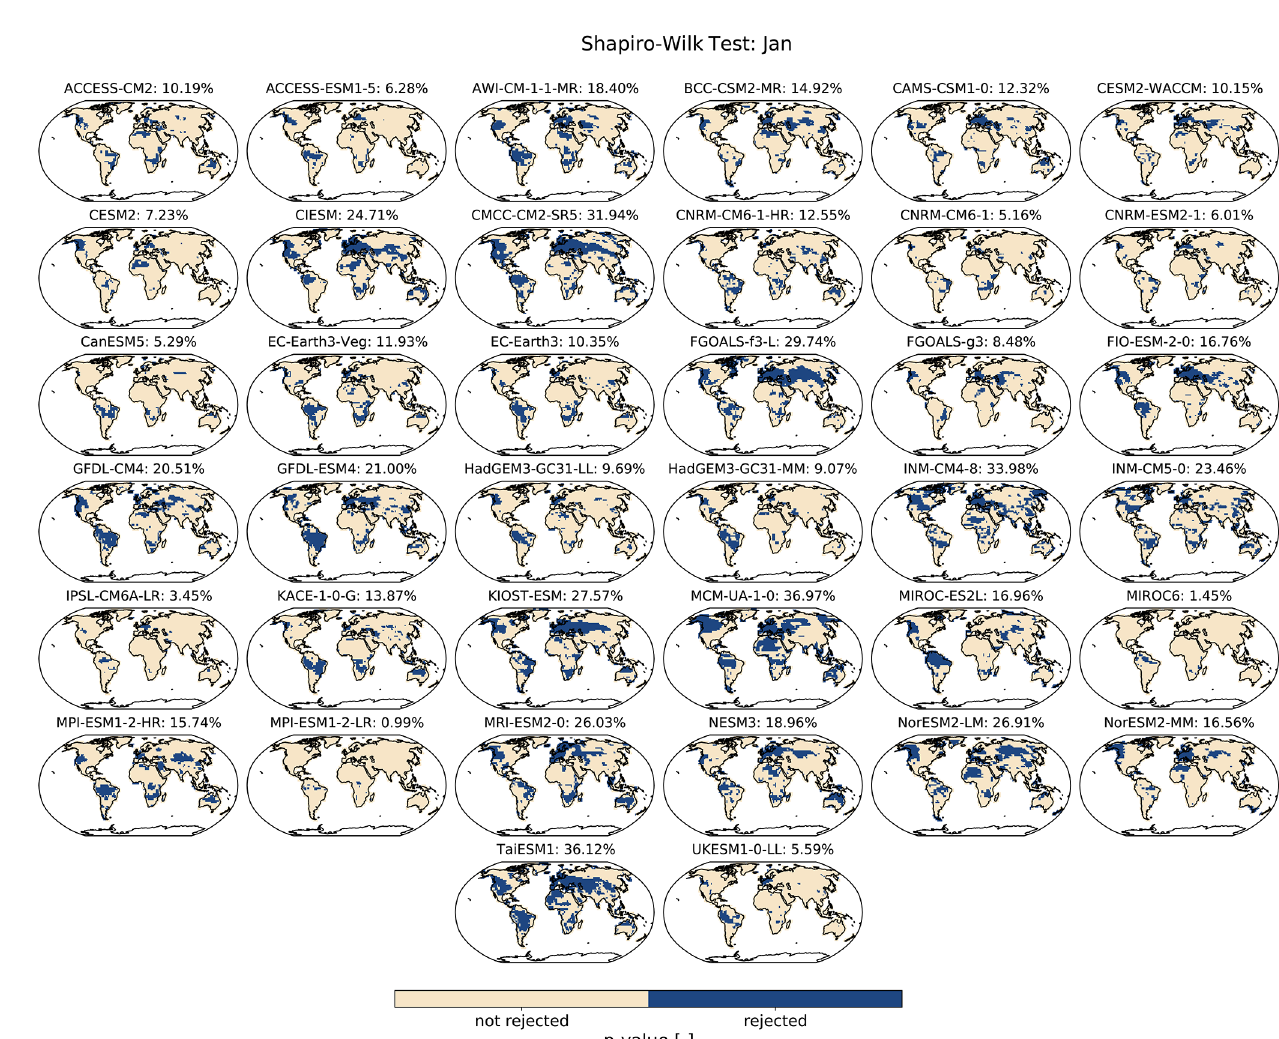
Figure B1. Shapiro–Wilk test for normality of January temperature residuals. The null hypothesis is that the residuals are normally dis- tributed. A Benjamini–Hochberg multiple test correction (Benjamini and Hochberg, 1995) is applied to the p values before plotting them. Percentage values indicate the proportion of grid points for which the null hypothesis is